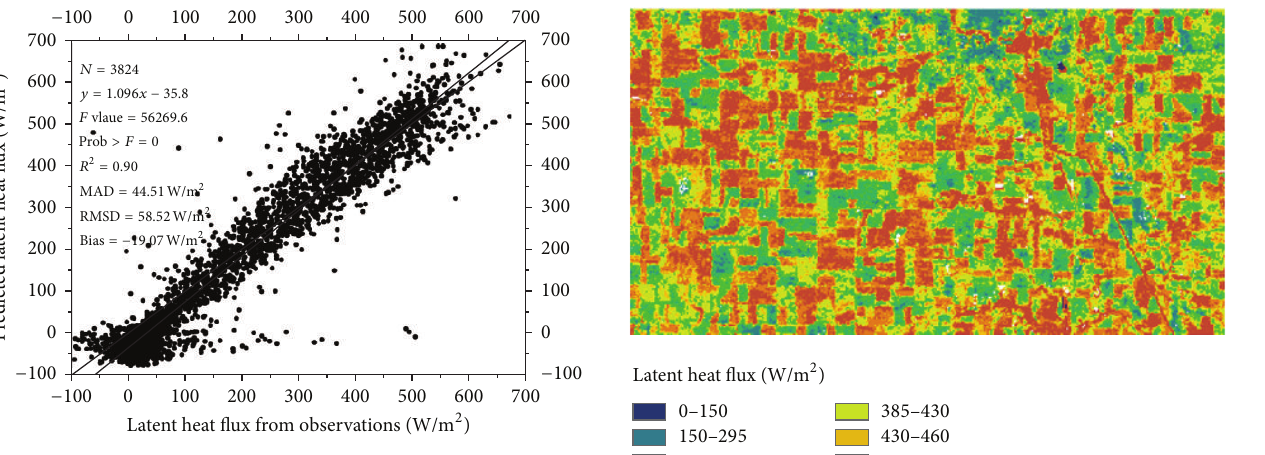
Figure 4: Model predicted latent heat flux (W/m 2 ) versus eddy covariance based observations for all corn sites from DOY171-190, 2002.